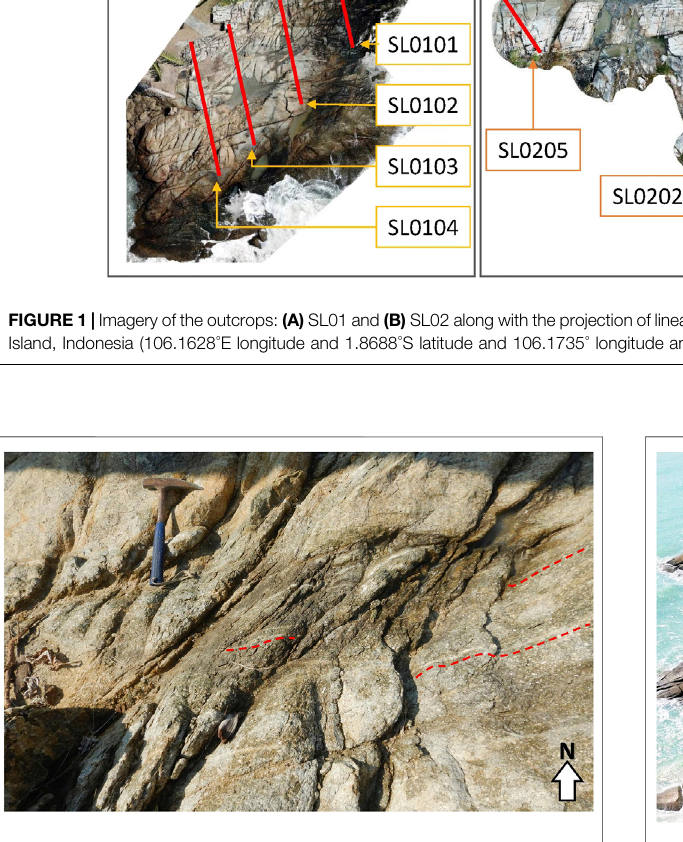
FIGURE3| Aerial viewofSL02. Atleast twofracture orientationscan be distinguished: an E-W (red dashed line) and a NE-SW (light blue dashed